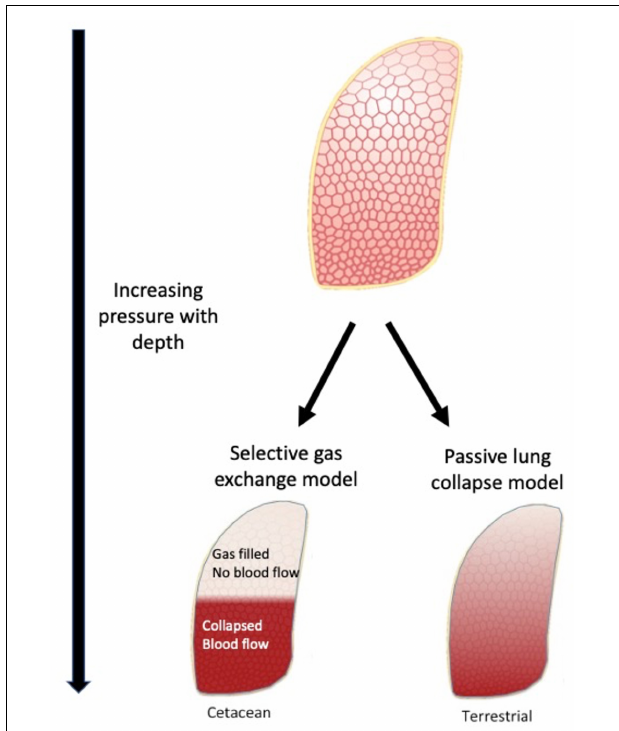
FIGURE 4 | The selective gas exchange hypothesis proposes that ventilation and perfusion matching in the lung during diving allows animals to selectively exchange O 2 and CO 2 while preventing exchange of N 2 . Based on the lung architecture, with extensive collateral ventilation, there is a distinct separation between a collapsed and open lung region. The collateral ventilation helps facilitate air escaping to the uppermost areas due to gravity and lower regions being atelectatic. With hypoxic pulmonary vasodilation, the lung is perfused in the lower region. This helps to provide a ventilation/perfusion match that favors exchange of O 2 and CO 2 but little or no exchange of N 2 . These differences will have a major impact on gas exchange and when properly matched provide selective exchange of gases. This model may explain heart rate arrythmias described in cetaceans, that may help increase O 2 and CO 2 exchange during periods of